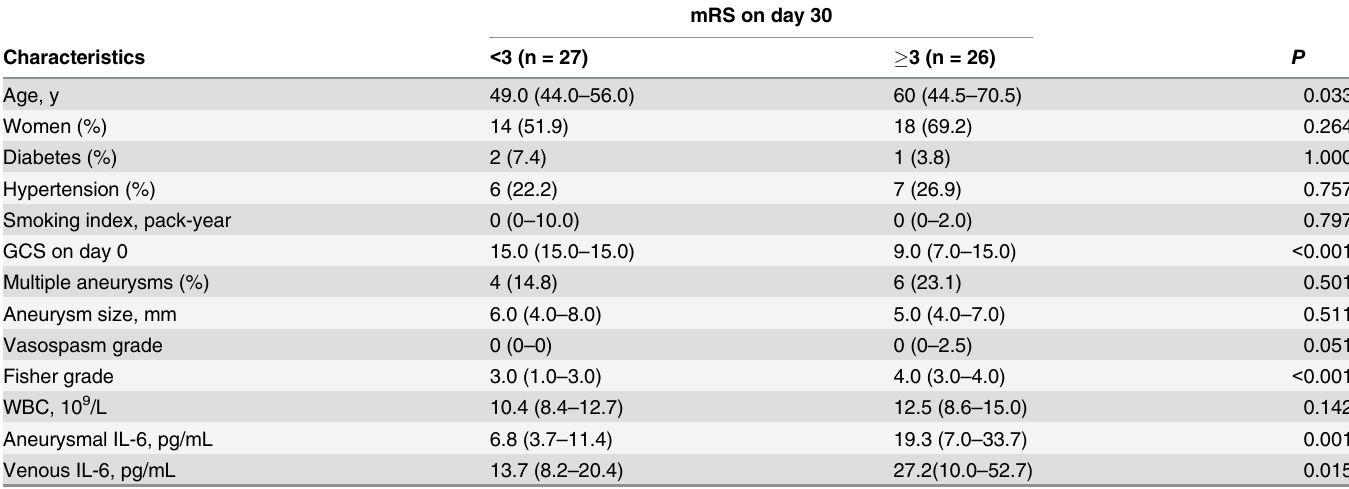
Table 1. Patient characteristics.